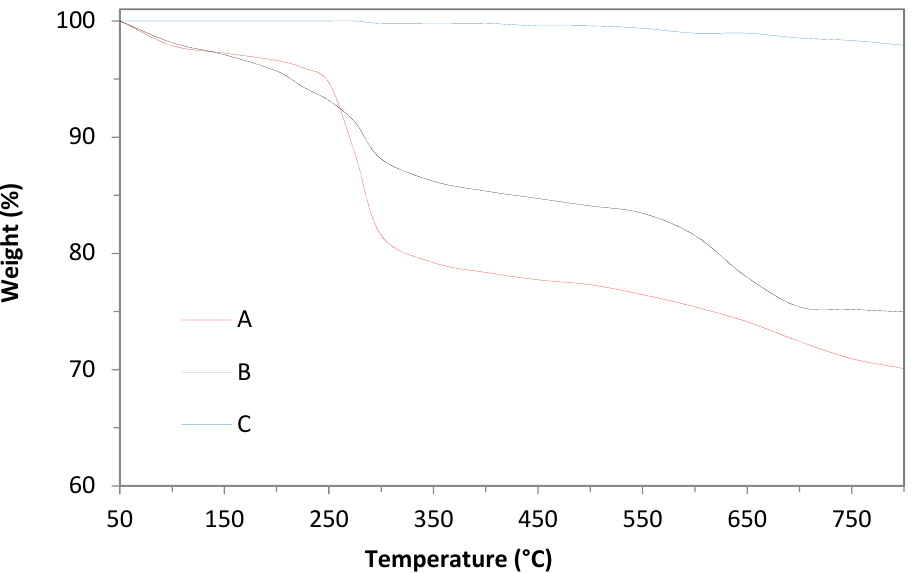
Figure 3. The TGA curves of the thermal decomposition of the produced wurtzite ZnS. Red (A) = washed with water for 5 min, black (B) = washed with acetone and ethanol for 5 min, blue (C) = commercial ZnS powder (UMICORE). The flow rate of N 2 was 20 mL min − 1 ; the heating rate equals 5 °C min − 1 .